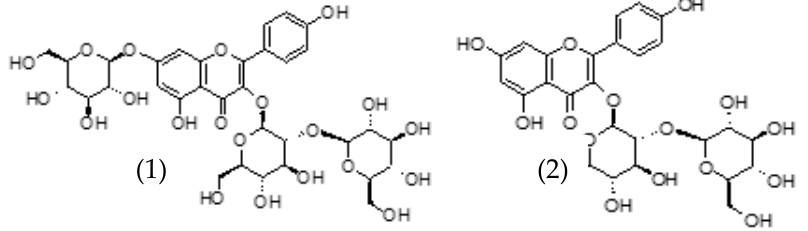
Figure 4. Structures of kaempferol 3- O - β -sophoroside 7- O - β -glucoside (1) and kaempferol 3- O - β -sophoroside (2) found in Crocus sativus L. [1].